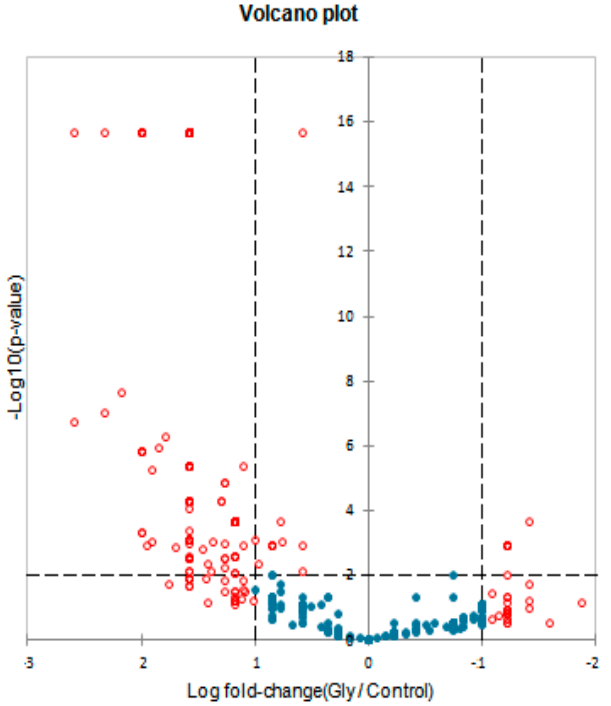
Figure 9. Volcano plot that displays and identifies statistically significant changes in protein expression in A. maxima samples treated with 0.2 mM glyphosate compared to the reference samples in terms of change in Log FC (X axis) and p -value (Y axis). XLSTAT 2021.3.1.1187- Differential expression feature. The details of the analysis are shown in Supplementary Tables S2 and S3.